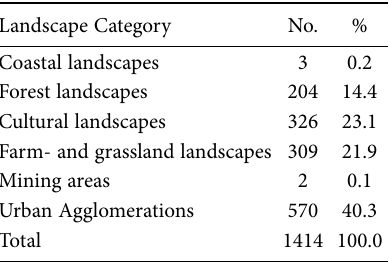
Table 2. Distribution of landscape